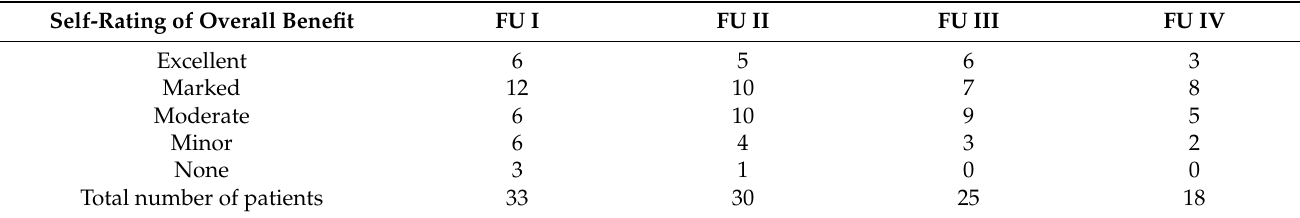
Table 4. Patient self-rating of overall benefit of chronic thalamic stimulation at the defined follow-up periods. Self-Rating of Overall Benefit FU I FU II FU III FU IV Excellent 6 5 6 3 Marked 12 10 7 8 Moderate 6 10 9 5 Minor 6 4 3 2 None 3 1 0 0 Total number of patients 33 30 25